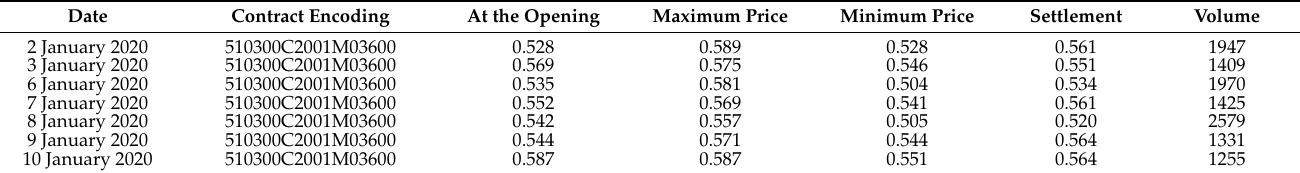
Table 2. Experimental sample data table.